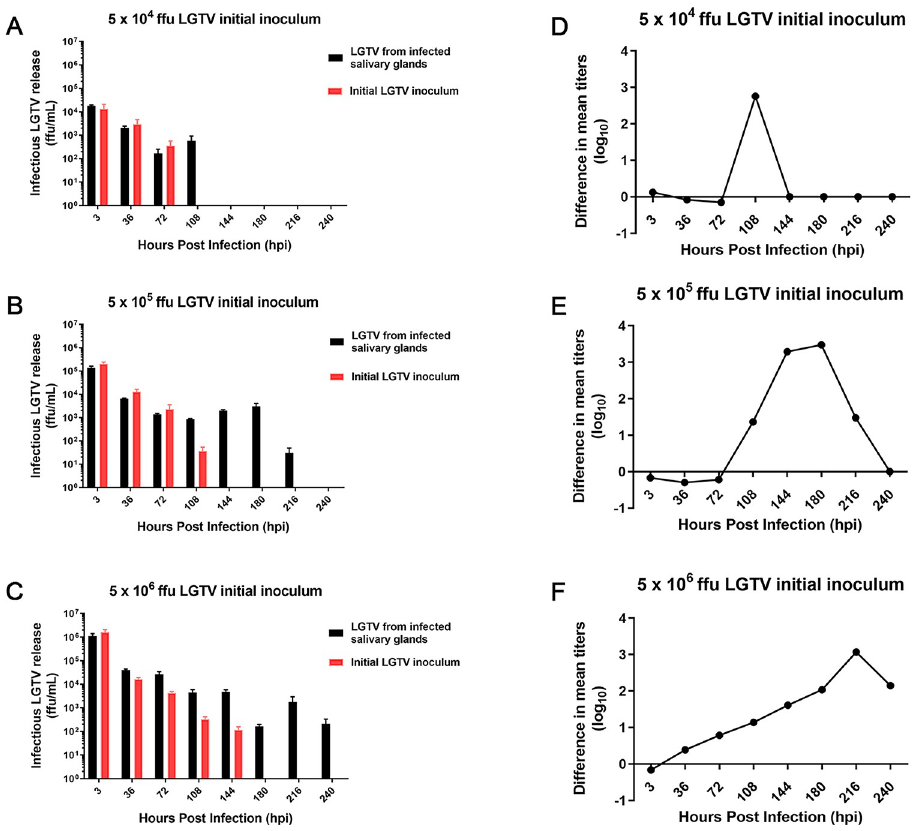
Fig 2. LGTV titer from infected male SG cultures. Infectious virus release from Langat virus (LGTV)-infected male I . scapularis salivary glands (SGs) was quantified using immunofocus assays. Experimental and control samples were inoculated with 5 x 10 4 (A), 5 x 10 5 (B), and 5 x 10 6 (C) focus-forming units of LGTV. Immunofocus assays were performed using supernatants collected from experimental wells with SGs infected with LGTV and control wells with LGTV inoculum and no SGs. Error bars represent the standard error of the means. Viral titers per timepoint were averaged and the log 10 values were calculated. Initial inoculum (control) logarithmic values were then subtracted from the corresponding infectious virus release logarithmic values per timepoint to visualize timepoints of peak virus release (D-F). These data are representative of 2–3 biological replicates and 2 technical replicates per timepoint. Data were processed using GraphPad Prism software